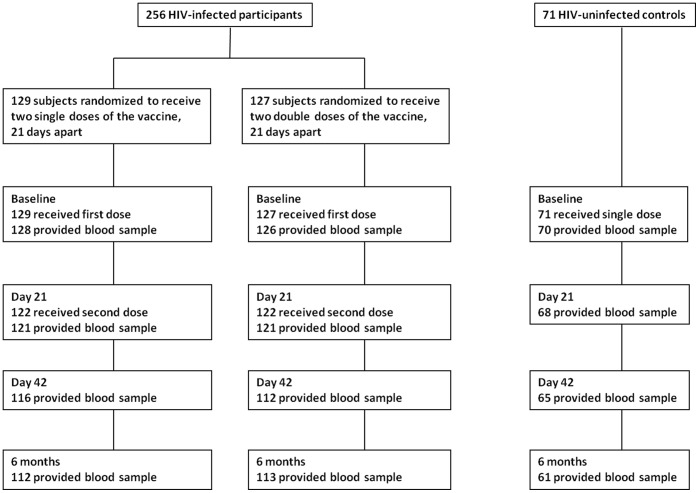
Participant disposition: enrollment, study procedures and participant disposition.